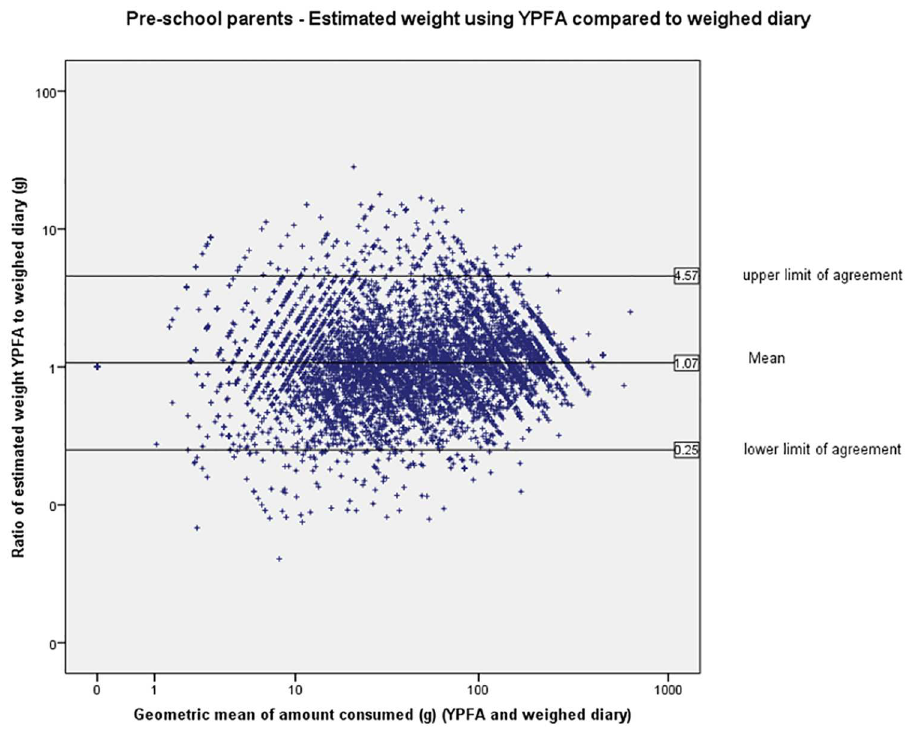
Fig 3. Pre-school parents—Bland-Altman plot showing estimated weight using YPFA compared to weighed diary. Note the data points show the individualestimate of food weight using the YPFA dividedby the weight recordedfor that food in the weigheddiary. A value > 1 indicatesoverestimation of portion size using the YPFA and a value of < 1 indicatesunderestimation using the YPFA. If the mean line is at 1 this would indicatethat there is no bias of one method relative to the other, and the degreeof agreement at the group level is indicatedby the limits of agreement, within which 95% of observations